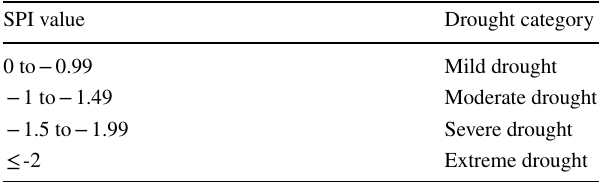
Table 1 Classification of drought conditions according to the SPI val- ues